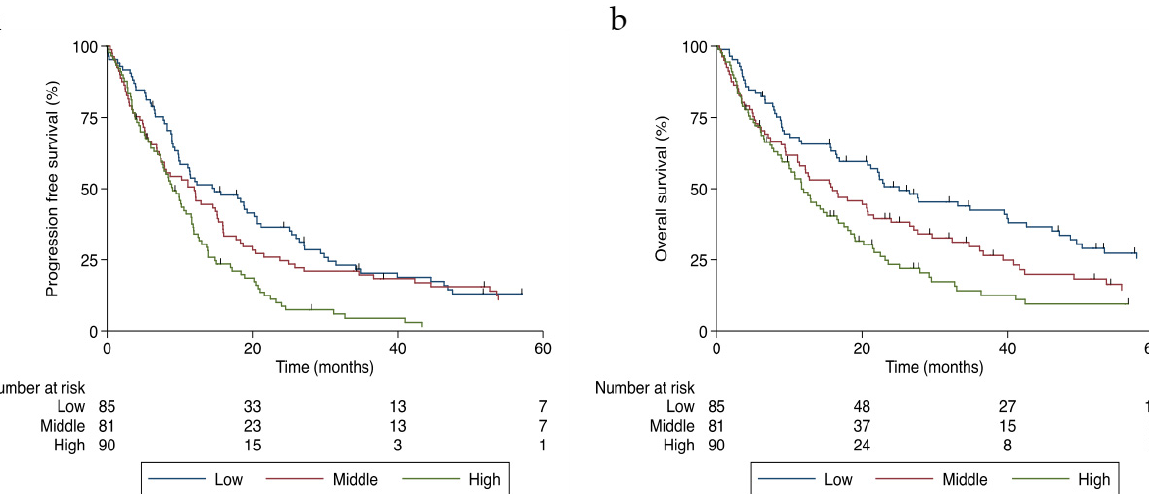
Figure 3 Survival curves of patients with stage I–III colorectal cancer divided by corrected calcium levels (in mg/dL): ( a ) disease-free survival and ( b ) overall survival . 4. Discussion